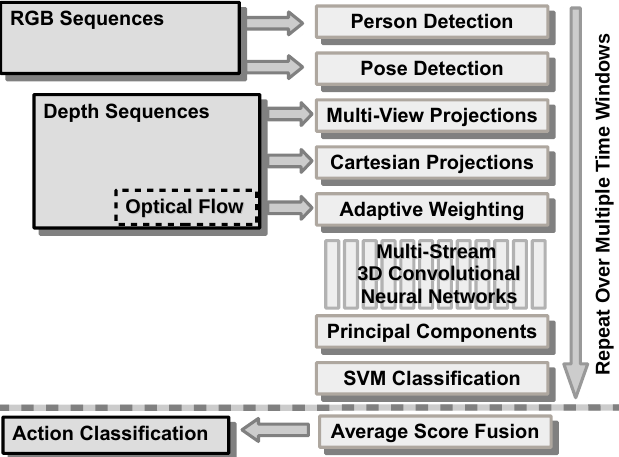
Figure 2. An illustration of the steps in the computer vision based action recognition